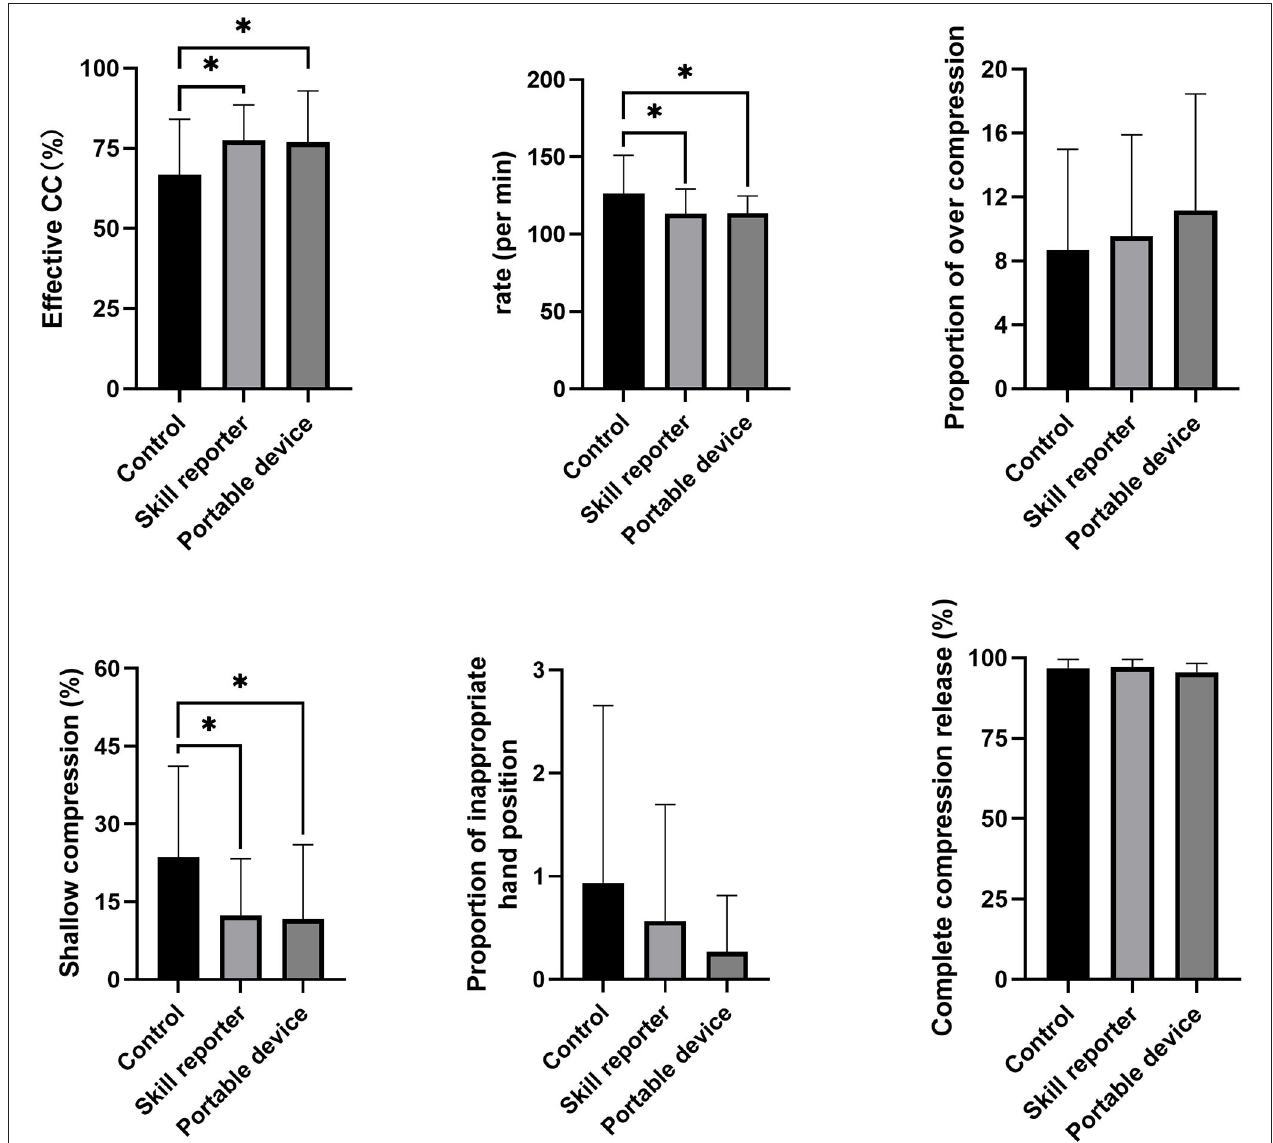
FIGURE 3 | Chest compression scores in the three groups. A significant difference was present in the proportion of effective CC rate, CC rate, and proportion of shallow CC. The statistical comparisons are discussed in the text. * p <